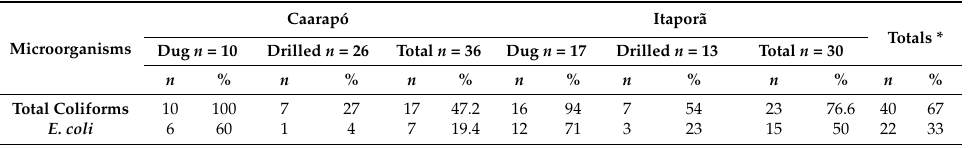
Table 2. Number of wells positive for total coliforms and E. coli in the cities of Caarapó and Itaporã, MS, Brazil (2014).